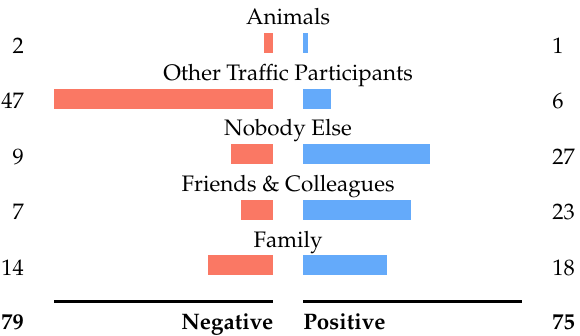
Figure 2. The influence of other traffic participants tends to spark negative experiences, whereas friends as passengers are mostly recollected in positive situations.